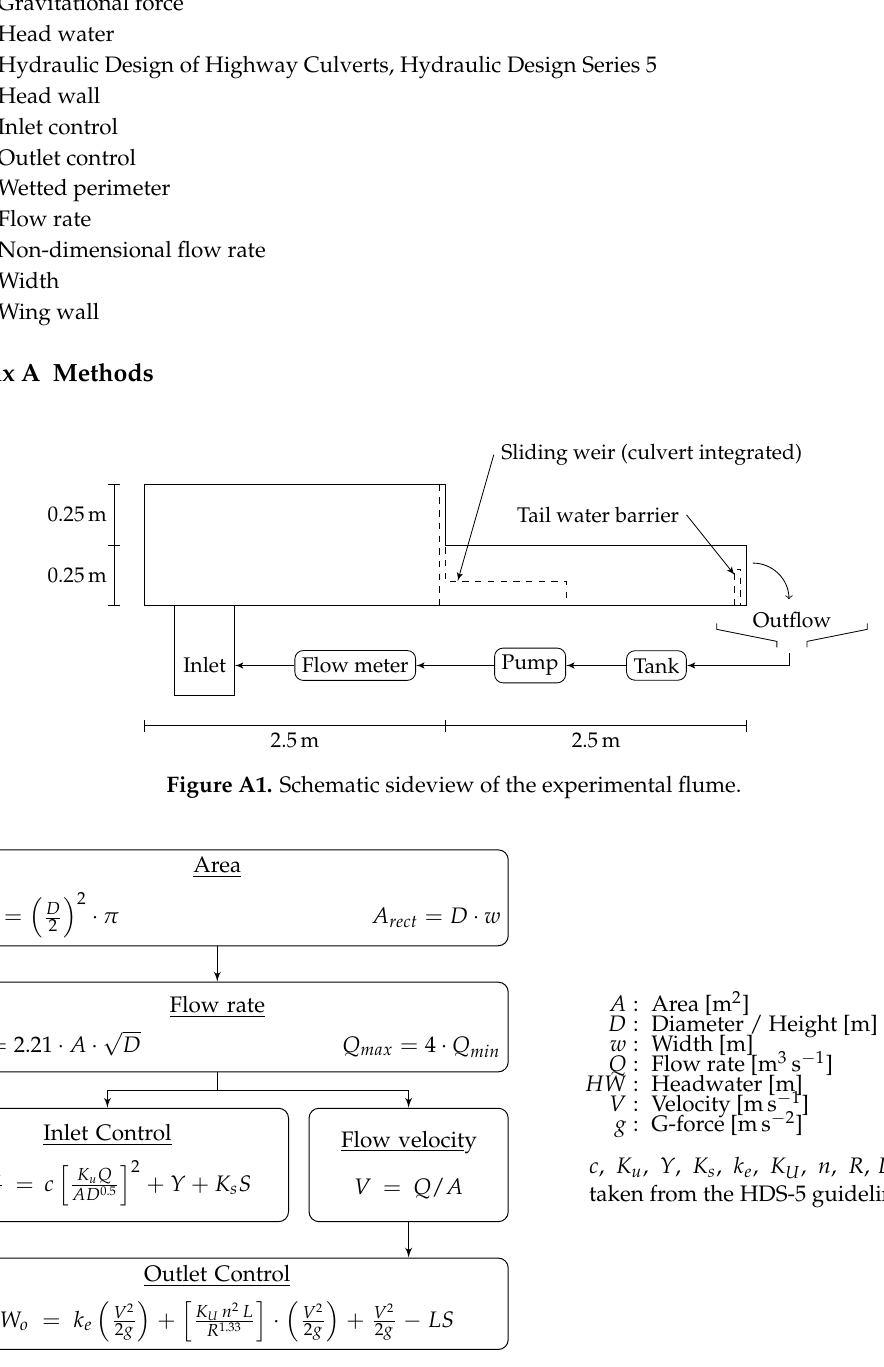
Figure A2. Calculation flowchart showing area calculations for rectangular and round shaped culverts and flow rate calculation for submerged inlets according to Reference [5]. Maximum used flow rate was 4 times larger than the minimum one; flow velocities only calculated for full flowing